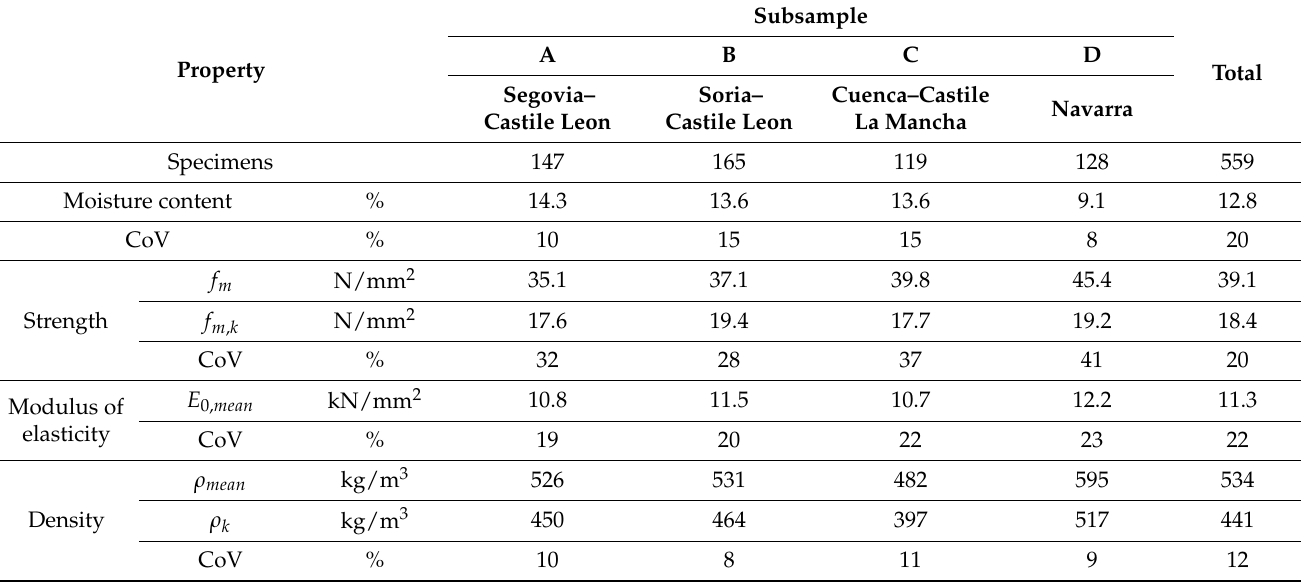
Table 4. Characteristic values of the mechanical and physical properties of Scots pine.